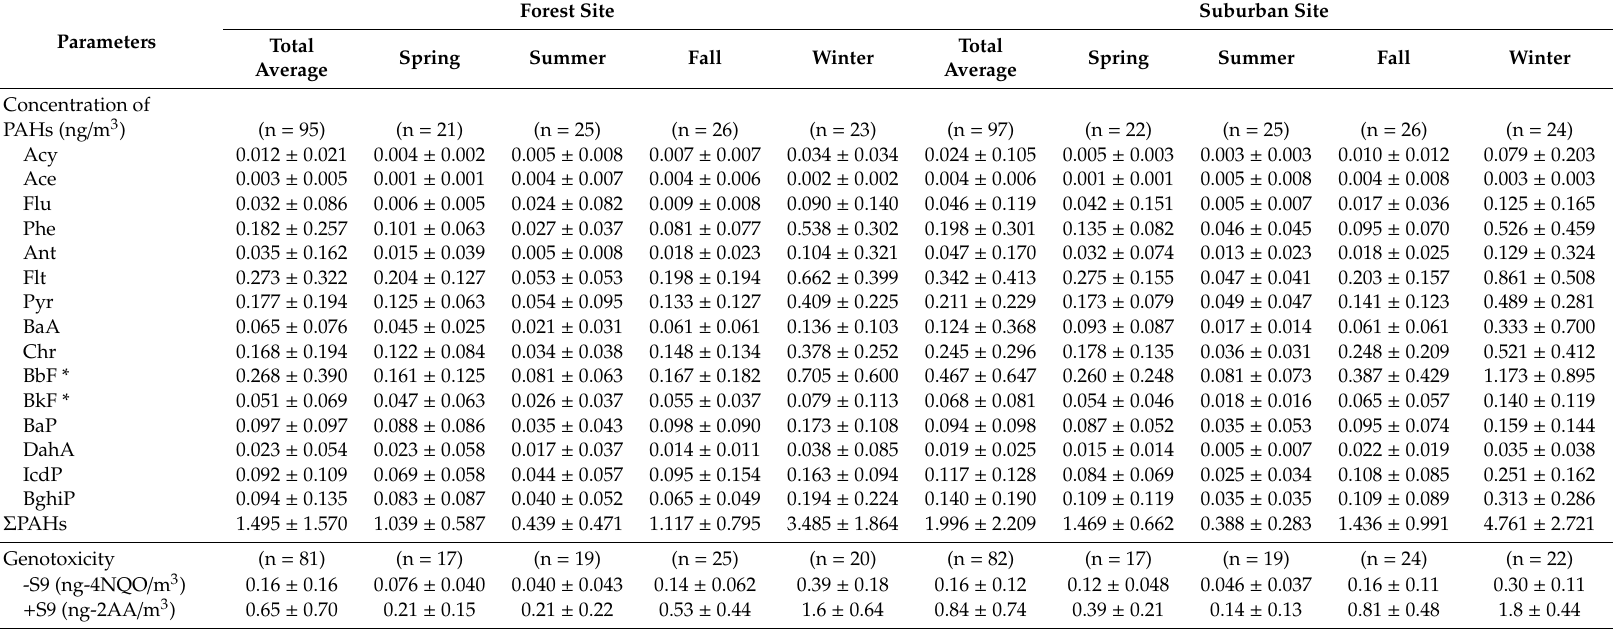
Table 1. PAH concentrations and genotoxicities of aerosols collected in Nagasaki from 2012 to